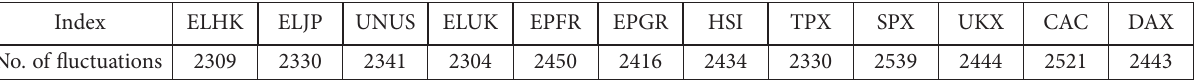
Table 5. No. of fluctuations of the 12 stock indices during the period of